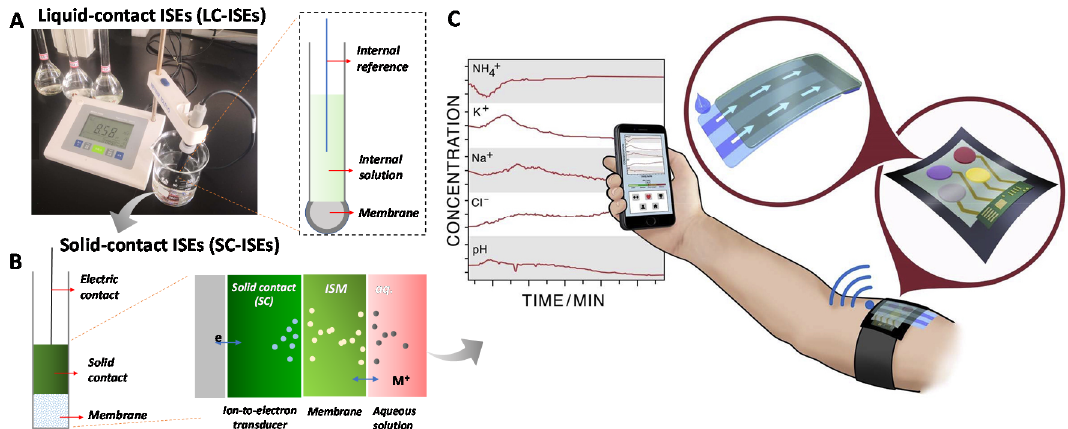
Figure 1. An overview from liquid-contact ion-selective electrodes (LC-ISEs) to solid-contact ISEs (SC-ISEs) for wearable sensors. ( A ) Classic LC-ISEs (e.g., pH meter) by a liquid-contact between internal solution and ion-selective membrane (ISM). ( B ) The structure of SC-ISEs by a solid-contact between solid ion-to-electron transducer layer and ISM. ( C ) An example of the SC-ISEs for wearable sensor applications [9].